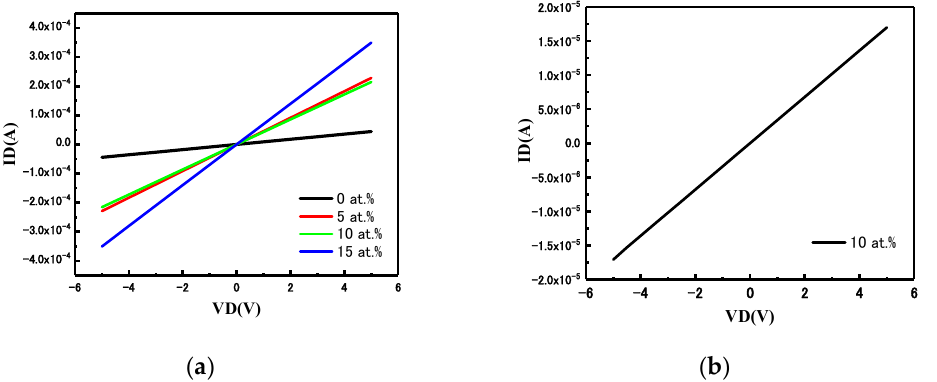
Figure 7. ( a ) The I-V characteristics of SnO 2 :Si films with different doping concentrations; ( b ) The I-V characteristics of SnO 2 :10 at.% Ga film.